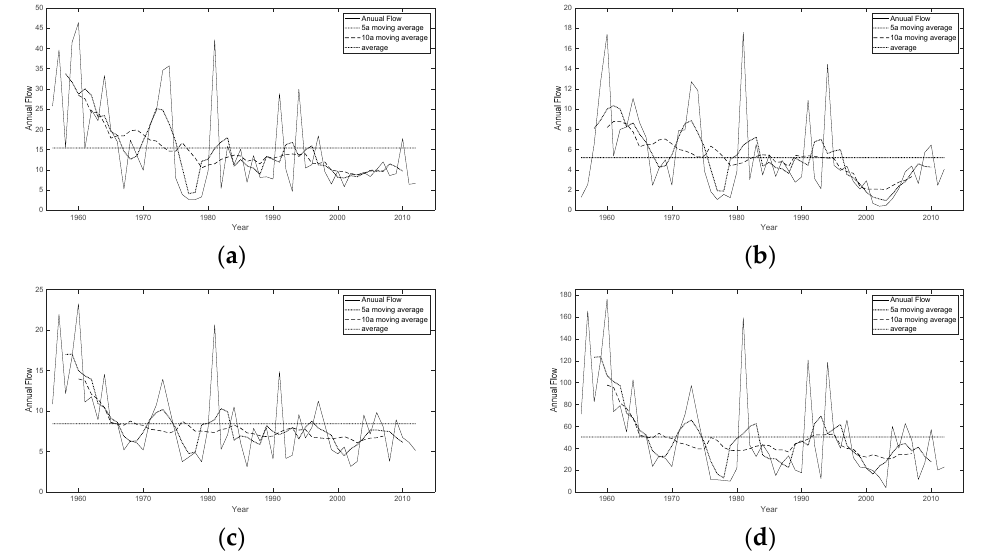
Figure 5. The mean annual flow from 1965 to 2012: ( a ) Baoqing station, ( b ) Baoan station, ( c ) Hongqiling station, and ( d ) Caizuizi station. The results of the hydrological alteration diagnosis system show a jump alteration in the GI series in 1966 at the Baoqing station, a trend alteration in 1990 in the GI series at the Baoan station, and jump variations in the GI series in 1987 and 1990 at the Hongqiling and Caizuizi stations, respectively. The alteration in the GI series of the Baoqing station occurred in 1966, and no obvious alteration was perceived in the GI series in the subsequent 46 years. Based on the alteration analysis above, runoff data from 1966 to 2012 were selected as the subsequence to calculate ecological flow at the Baoqing station. Runoff data for the periods 1956–1990, 1956–1987, and 1956–1990 were selected as the subsequence to calculate ecological flow at the Baoan, Hongqiling, and Caizuizi stations, respectively. Results of the hydrological alteration diagnosis system are shown in Table 1.